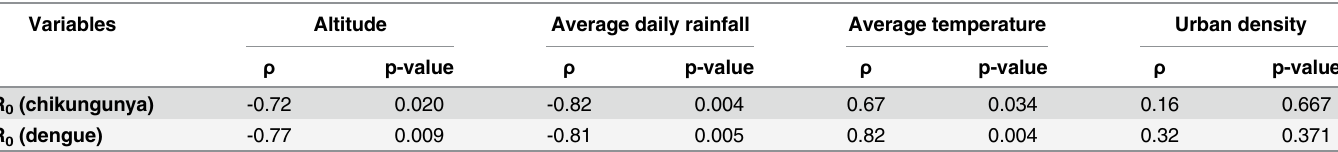
Table 3. Spearman ’ s correlation coefficients ( ρ ) between environmental variables and predicted peak of R 0 for chikungunya and dengue. Variables Altitude Average daily rainfall Average temperature Urban density ρ p-value ρ p-value ρ p-value